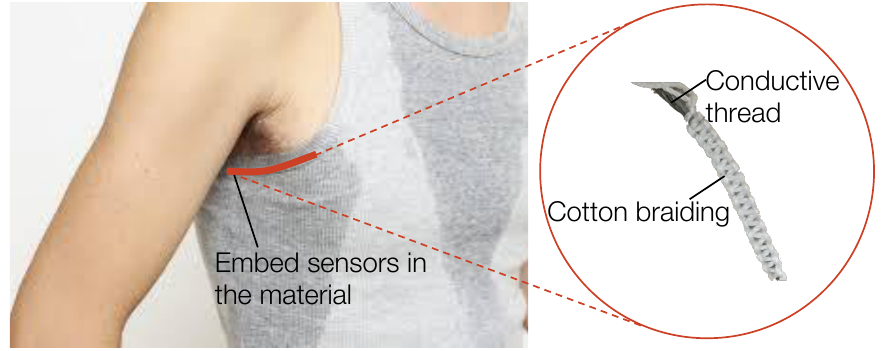
Figure 1. Sweat sensing through a conductive thread-based textile sensor with 3D structured cotton